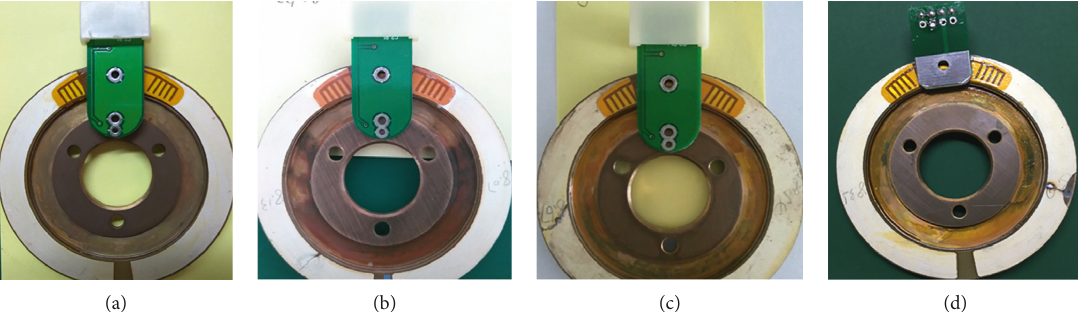
Figure 3: Piezoelectric ceramics of tested motors with four degradation states: (a) normal state; (b) slight degradation; (c) severe deg- radation; (d) failure